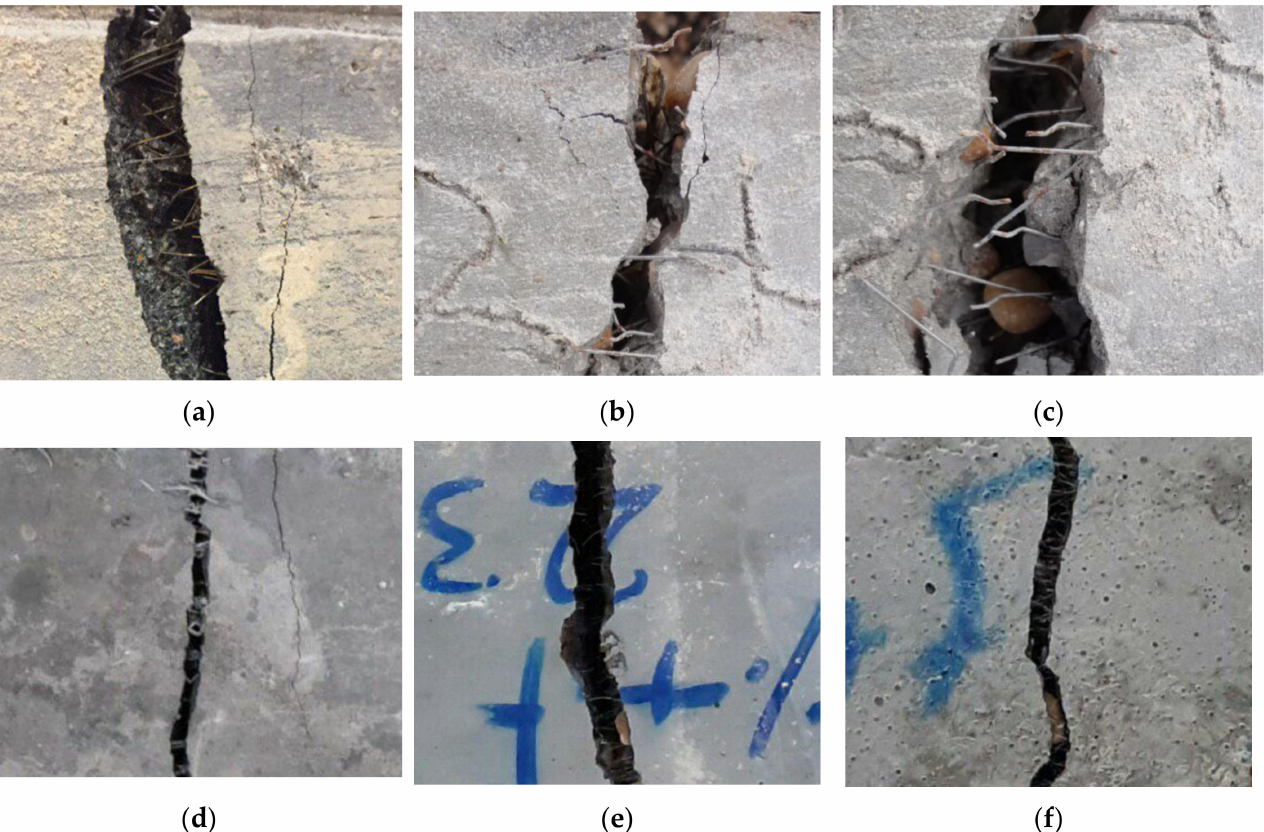
Figure 8. Flexural failure mode ( a ) crack of MSF-13, ( b ) crack of HSF-35, ( c ) crack of HSF-60, ( d ) crack of SYF-19, ( e ) crack of SYF-38, and ( f ) crack of